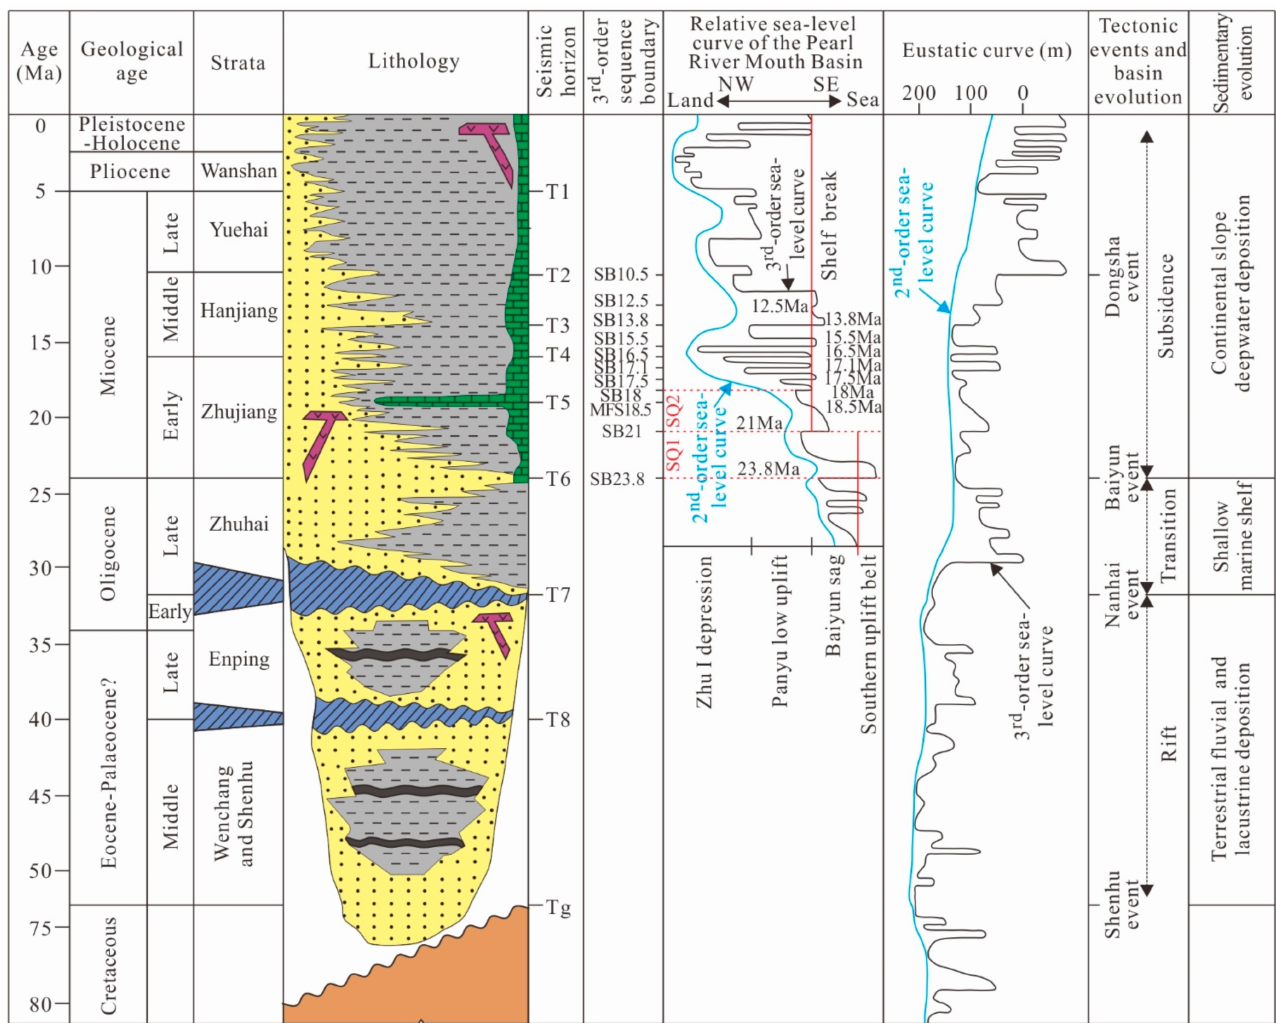
Figure 2. Stratigraphic Sequence framework for the Pearl River Mouth Basin. The red solid line shows approximated locations of shelf breaks. Colours of the lithology column: brown = basement rock; blue = erosion; yellow = sandstone; grey = mudstone; green = carbonate; black = coal deposits; violet = magmatic intrusive